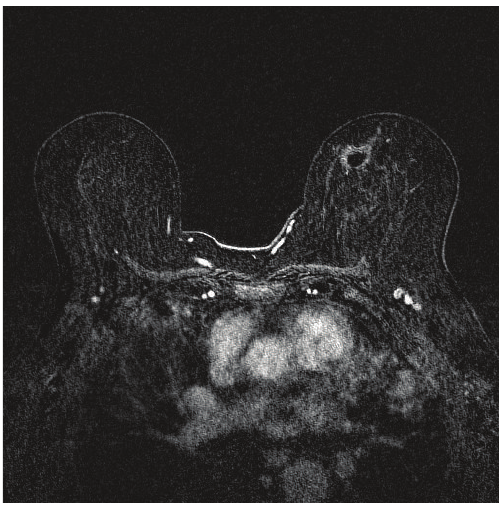
Figure 2: Subtraction MRI demonstrates a 0.9 cm enhancing mass with spiculated borders within the posterior left breast with no involvement of the left chest wall. This posterior mass was not appreciated on mammography. Under MRI guidance, this mass was biopsy proven to represent invasive pleomorphic lobular carcinoma.